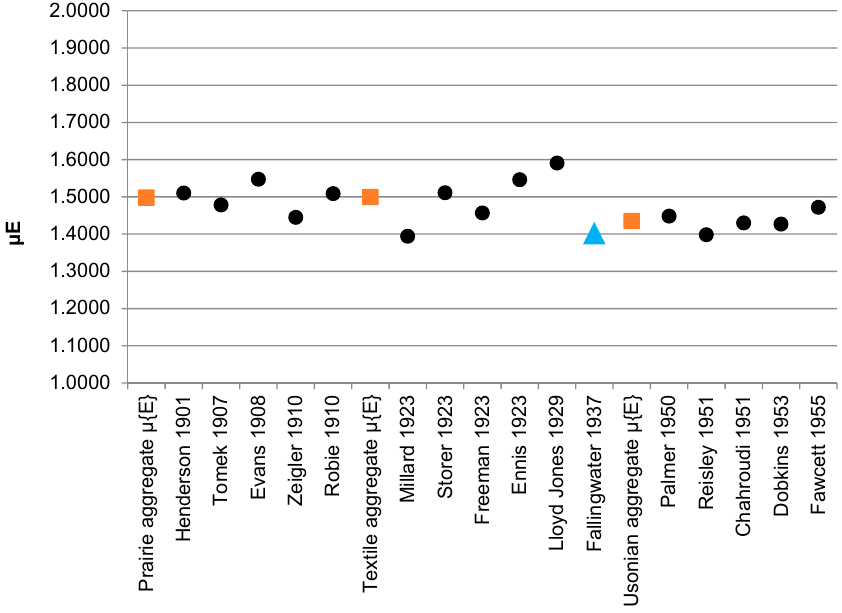
Figure 9. Elevation results: mean [  ]and aggregate [  ] D compared with Fallingwater [  ].